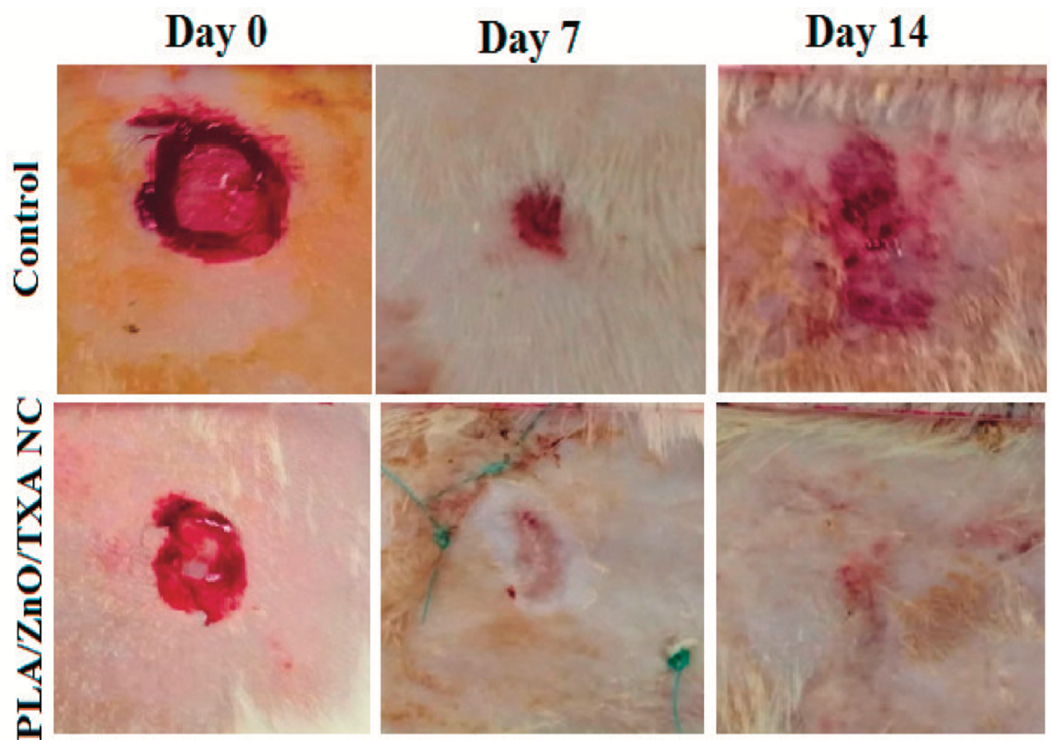
Figure 15. Images of skin wound healing process in mice after 0, 7, and 14 days of treatment with the PLA/ZnO/TXA nanocomposites [203].